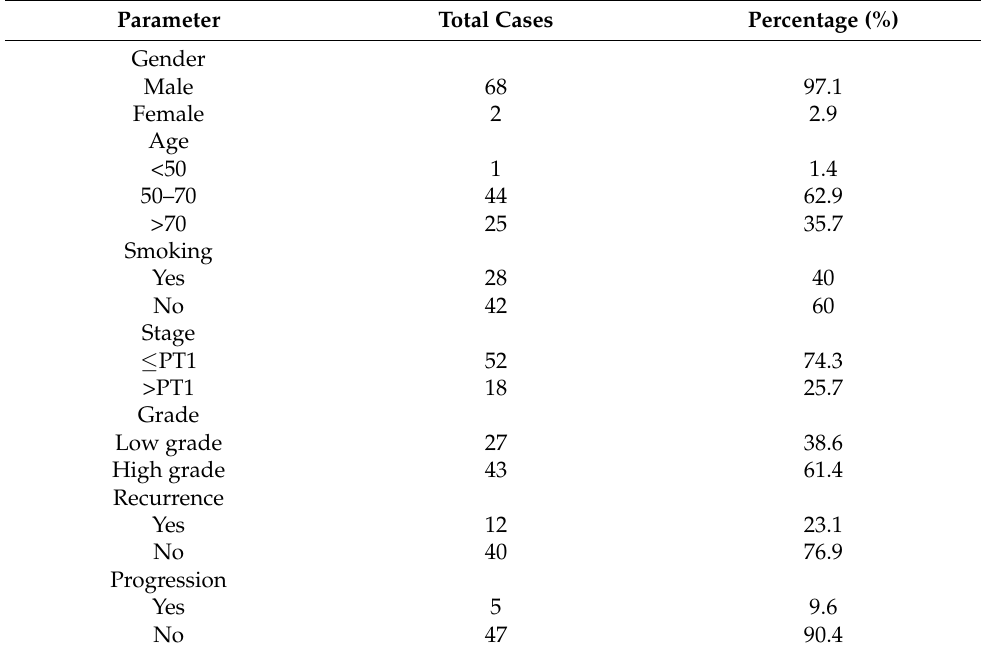
Table 2. Tumor characteristics of recruited